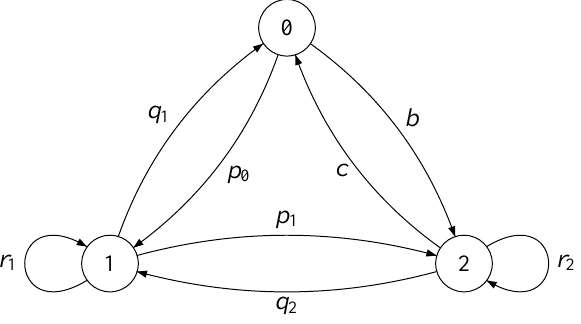
Fig. 4: The randomization of the particular case analyzed in this